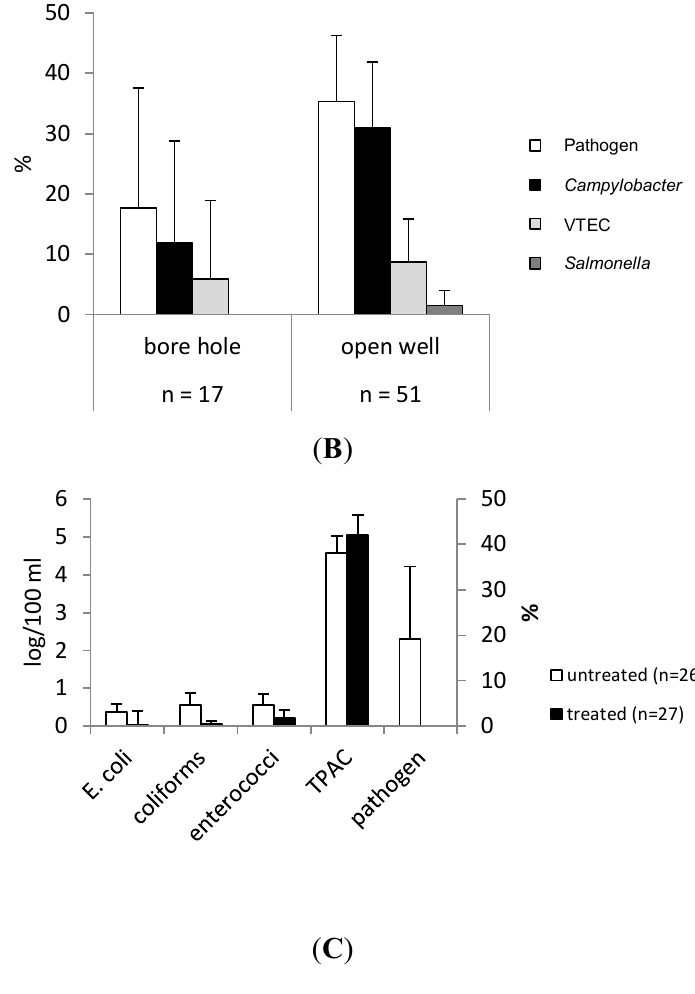
Figure 4. Degree of contamination of the different indicator bacteria (log CFU/100 ml) ( A ) and pathogens (presence/absence in 1 l) ( B ) for borehole water (farms 3 and 4) and open well water (farms 1, 2, 5–8). ( C ) Impact of water treatment on the indicator bacteria and pathogens by comparing treated and untreated water for three farms applying water treatment (farms 1, 3 and 4). Bars show the 95% confident